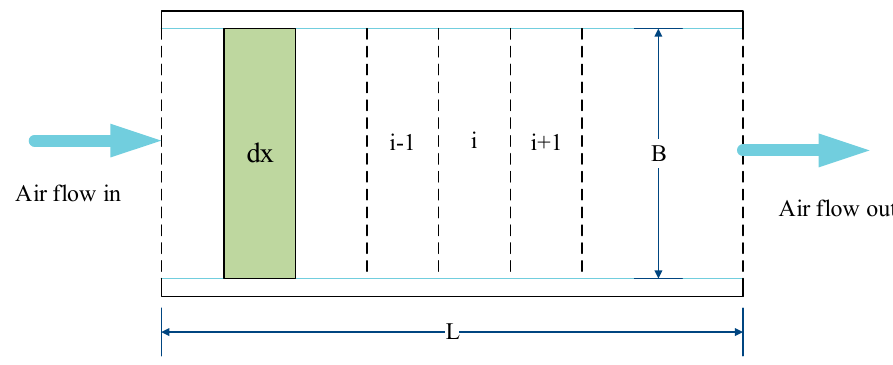
Figure 2. Differential control volume for one channel.